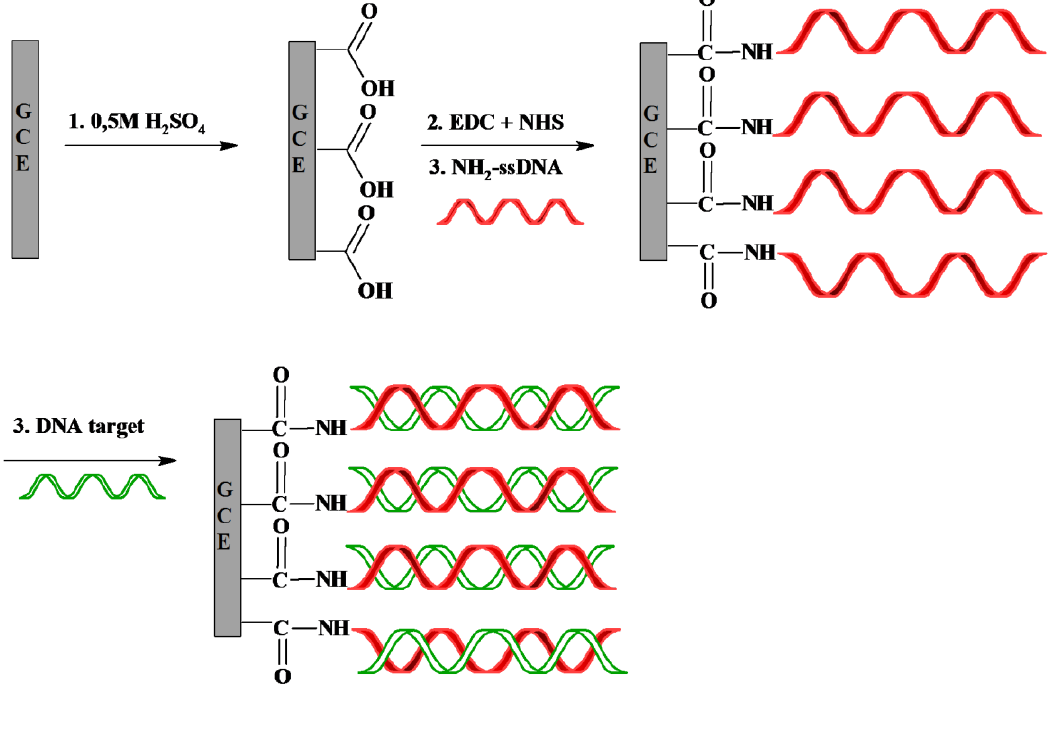
Figure 1. Schematic representation of the proposed